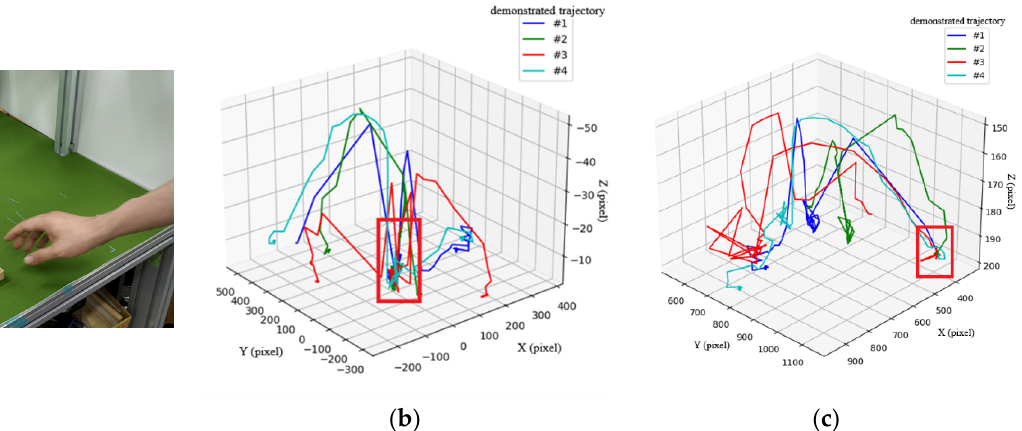
Figure 12. Scenario 3: “pick up a spoon, stir in a cup, and place the spoon at a fixed position”. ( a ) Experimental environment; ( b ) relative trajectory (type-3) from the cup to the spoon through four demonstrations to induce a key path indicated by a red box; ( c ) absolute trajectory (type-1) of the spoon through four demonstrations to induce a key path indicated by a red box.